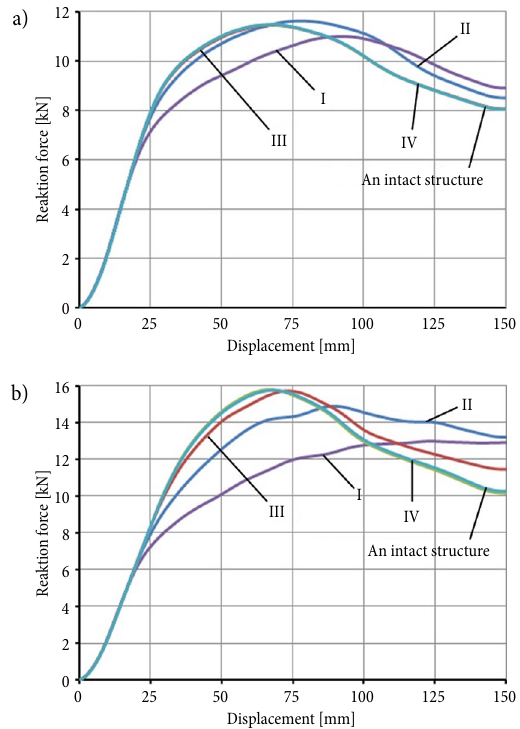
Fig. 14. Reactions of A-pillar support